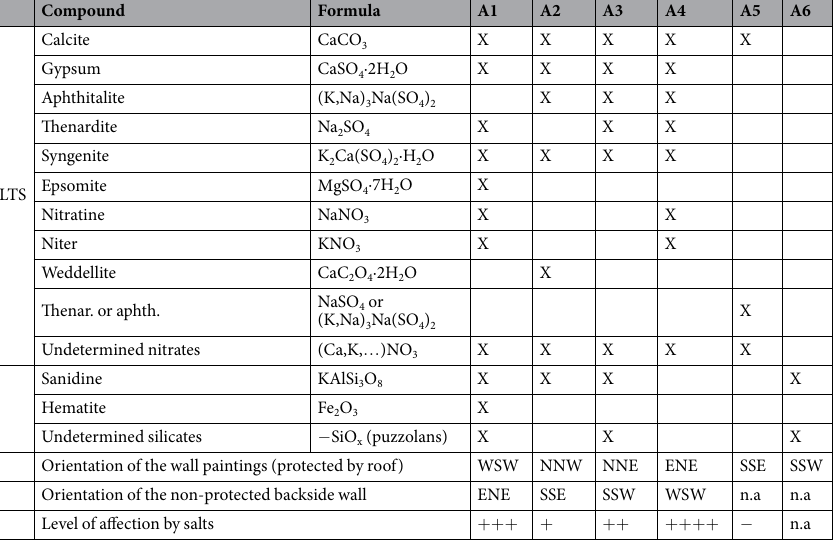
Table 1. Summary of the different compounds identified in the different walls of the peristyle in the House of Gilded Cupid (Pompeii), the orientation of the non-protected backside of the measured wall and the level of affection by salts calculated by the predominance of salts in the measurements (n.a: not